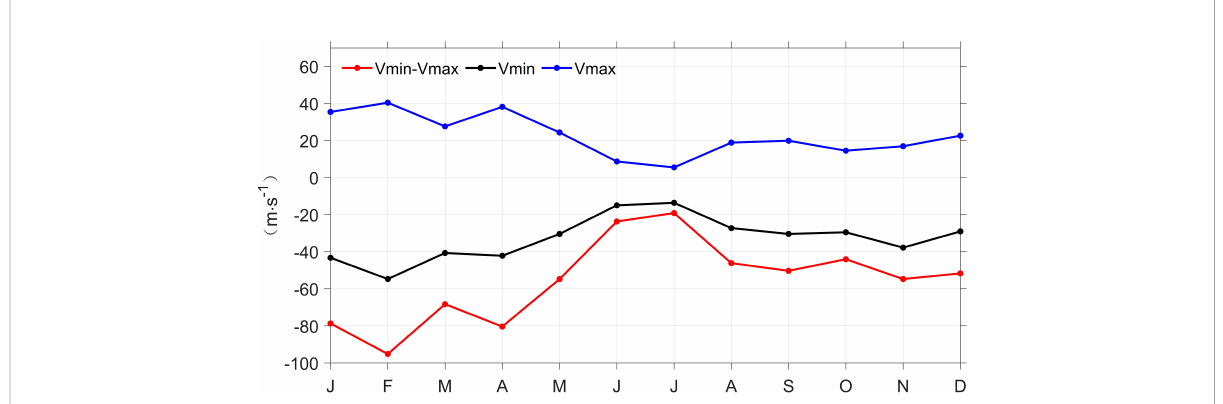
FIGURE 11 Seasonal variation of velocity of the EAC southern extension (Vmin, units: cm s -1 ), the EAC recirculation (Vmax, units: cm s -1 ), and the difference between the two currents (Vmin-Vmax, red line, units: cm s -1 ) along 38°S. The black line is Vmin, the blue line is the Vmax, and the red line is Vmin-Vmax averaged over the upper 300 m layer from OFES during July 1999-October